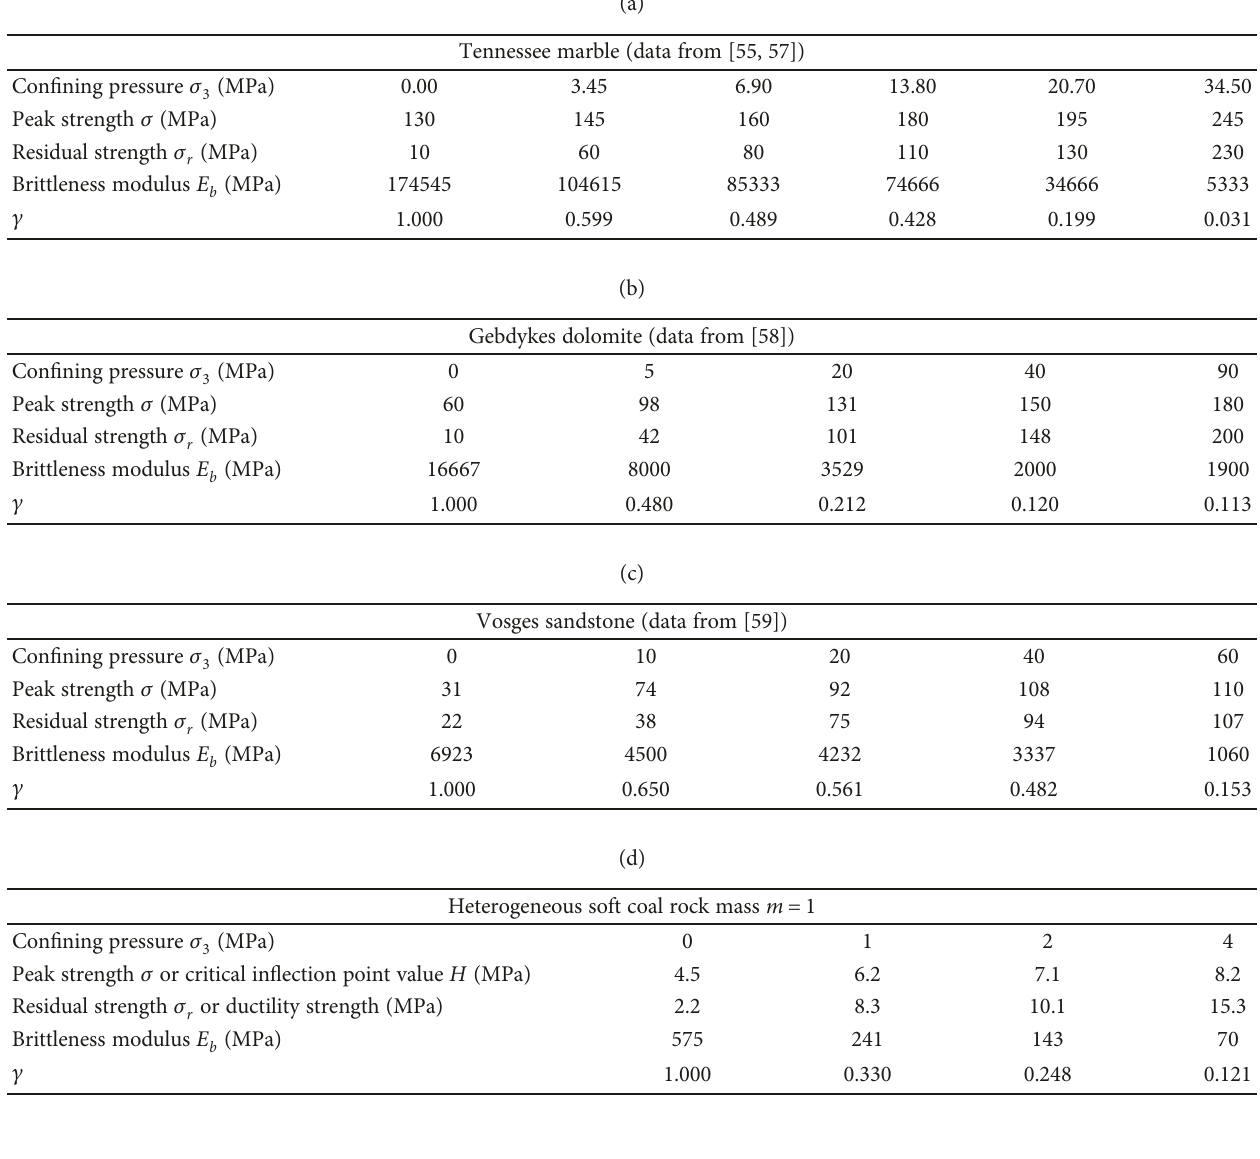
Table 2: Brittle-ductile modulus for di ff erent